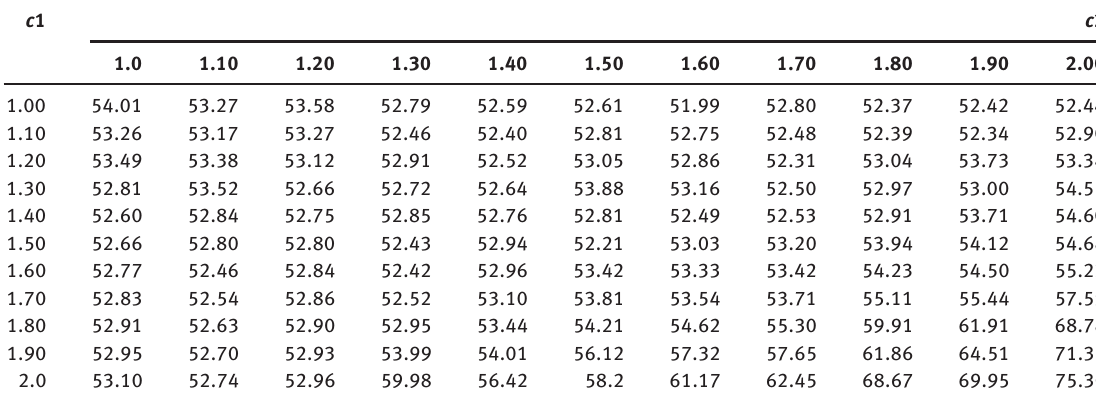
Table 1. Optimization Results of Different Parameters Combination of c 1 and c